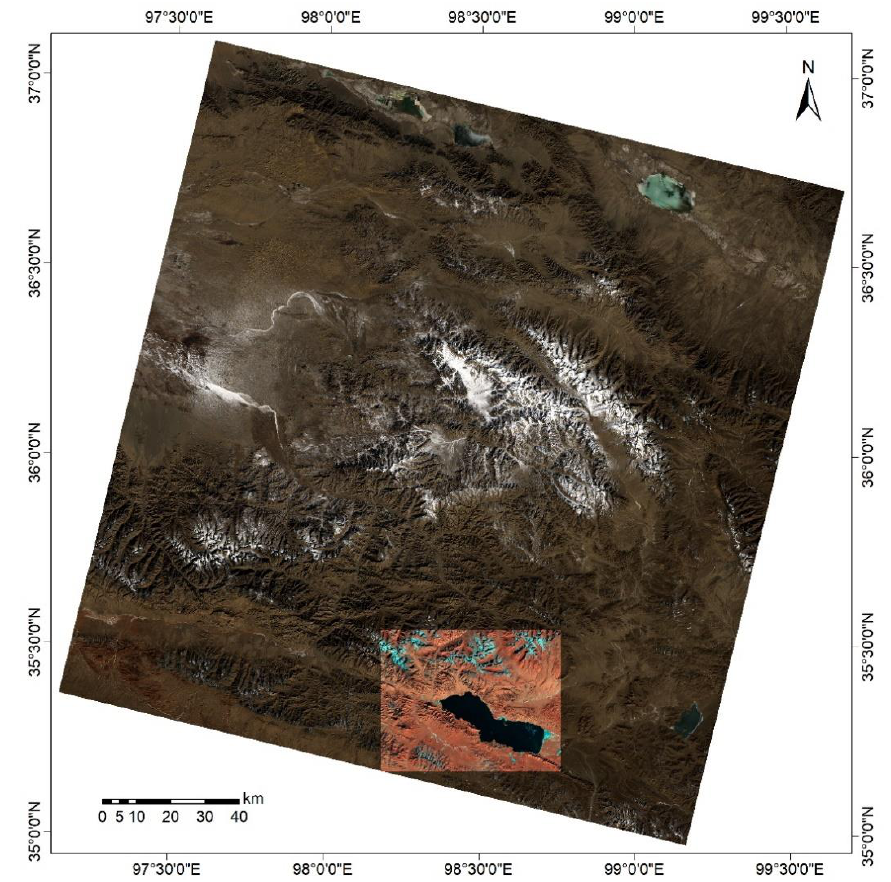
Figure 2. Study area: Donggei Cuona Lake (Path/ROW 134/35